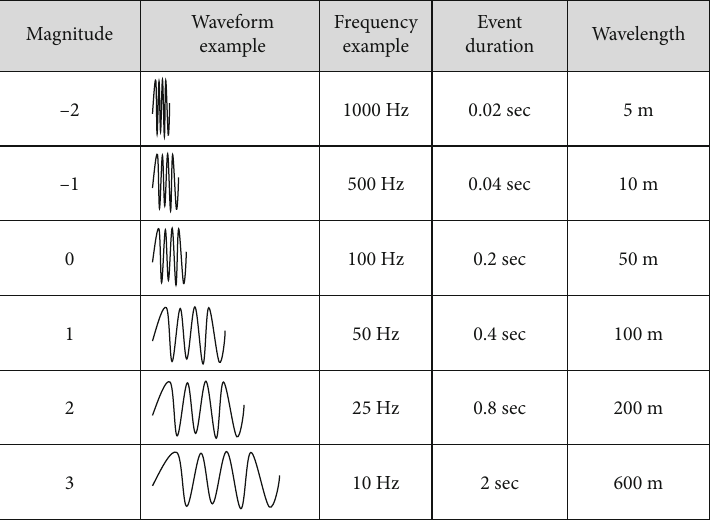
Figure 11: Example of microseismic energy and signal